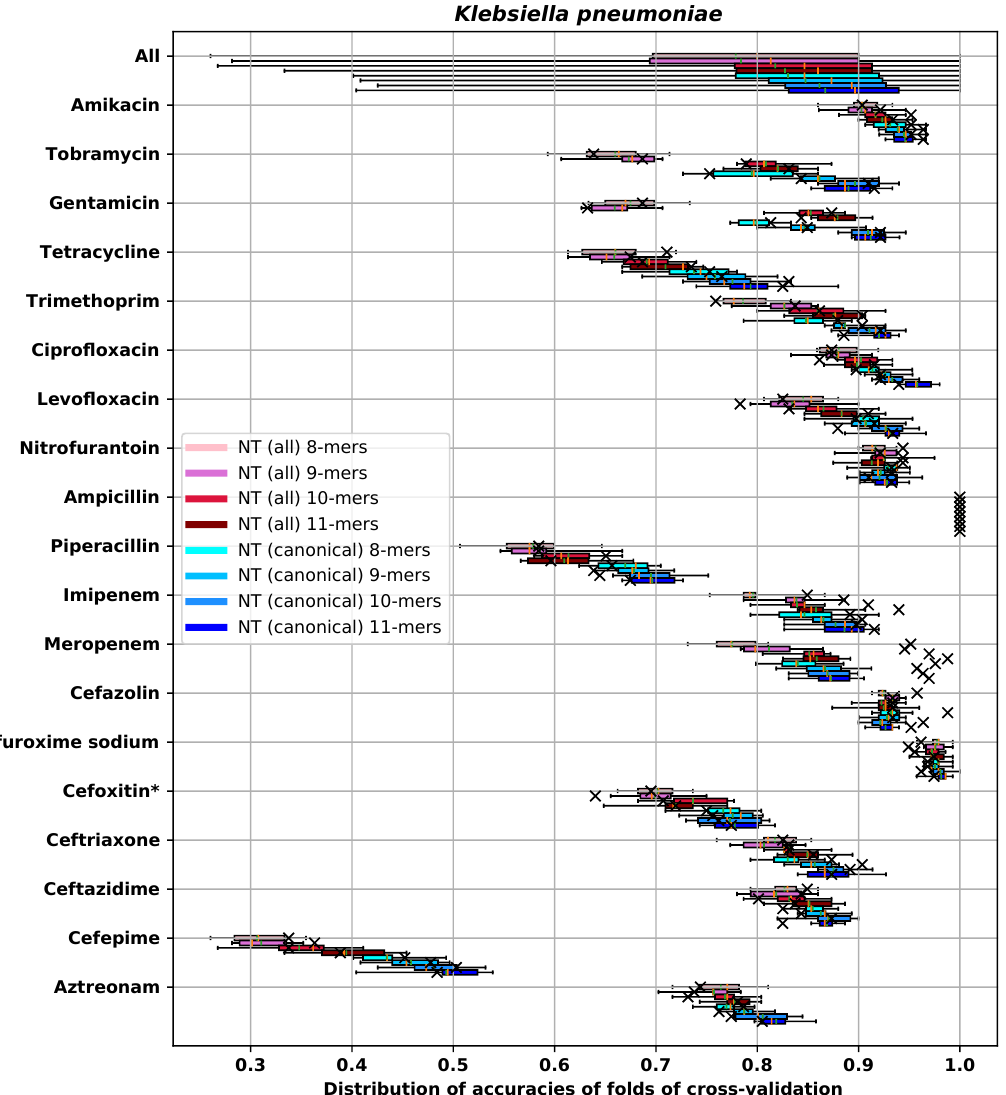
Figure A10. Distribution of accuracies in different nucleotide k -mers for K. pneumoniae . Plots are similar to Figure